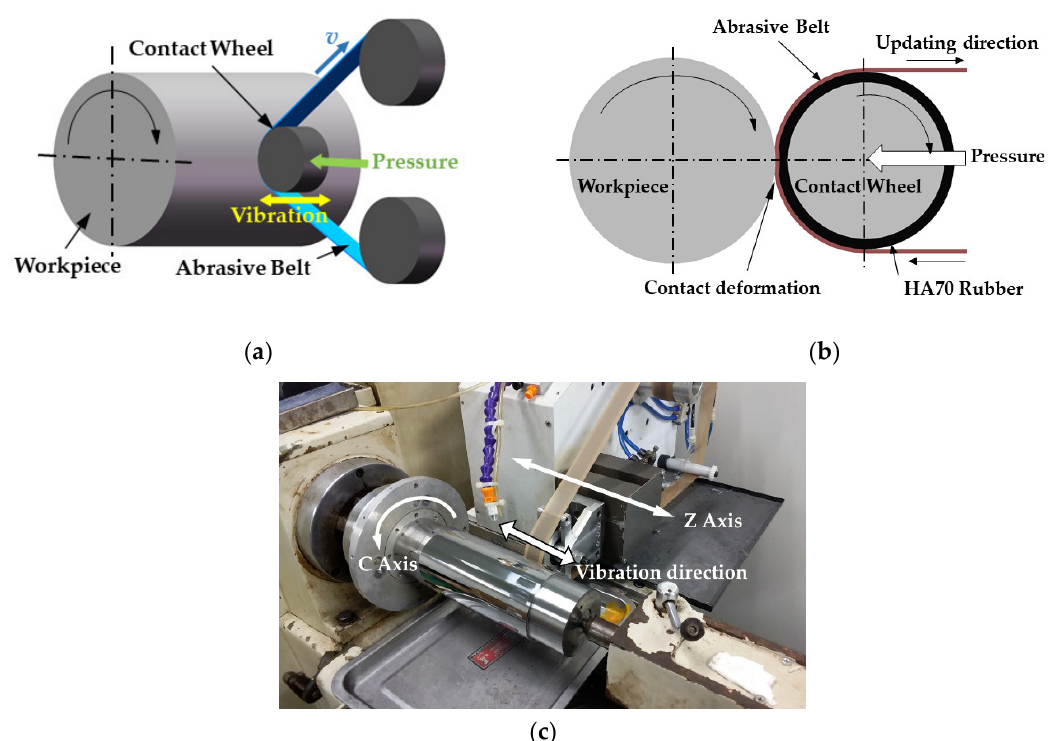
Figure 1. Schematic diagram of deterministic grinding with vibration-assisted abrasive belt: ( a ) three- dimensional schematic diagram; ( b ) two-dimensional schematic diagram; ( c ) actual diagram of the system.